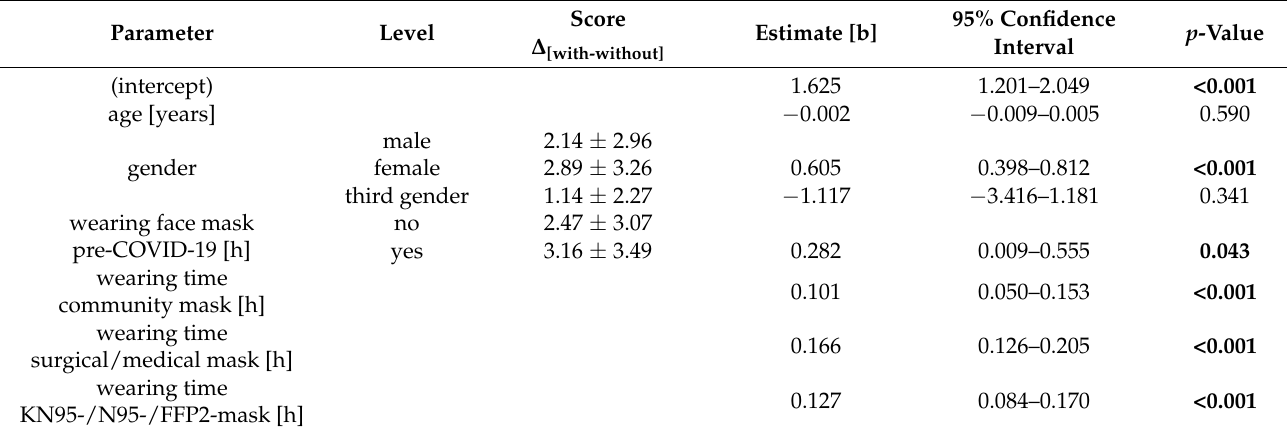
Table 2. Descriptive statistics of single parameters regarding the change in summated dry mouth score (mean ± standard deviation) and effect estimates, 95% confidence intervals and p -values from multiple linear regression analysis.